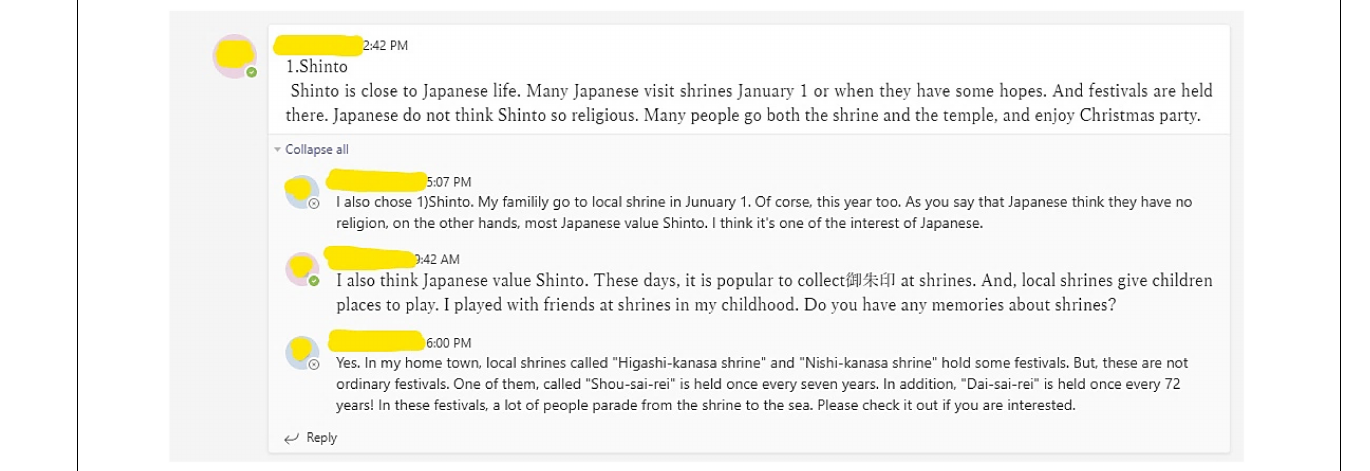
FIGURE 4 | Asynchronous discussion board. Microsoft and Microsoft Teams are trademarks of the Microsoft group of